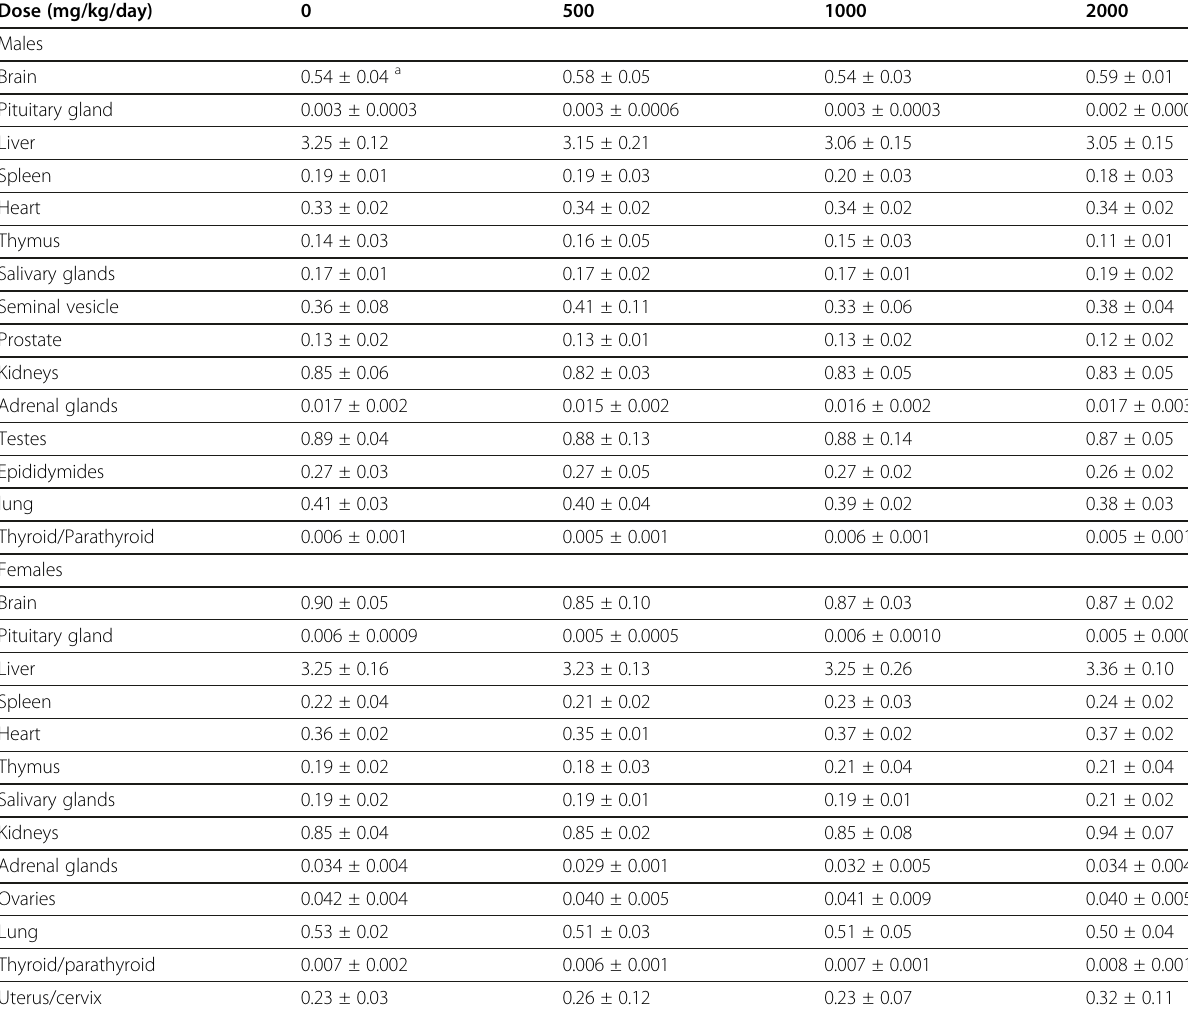
Table 2 Relative organ weights male rats treated with SST for 4 weeks Dose